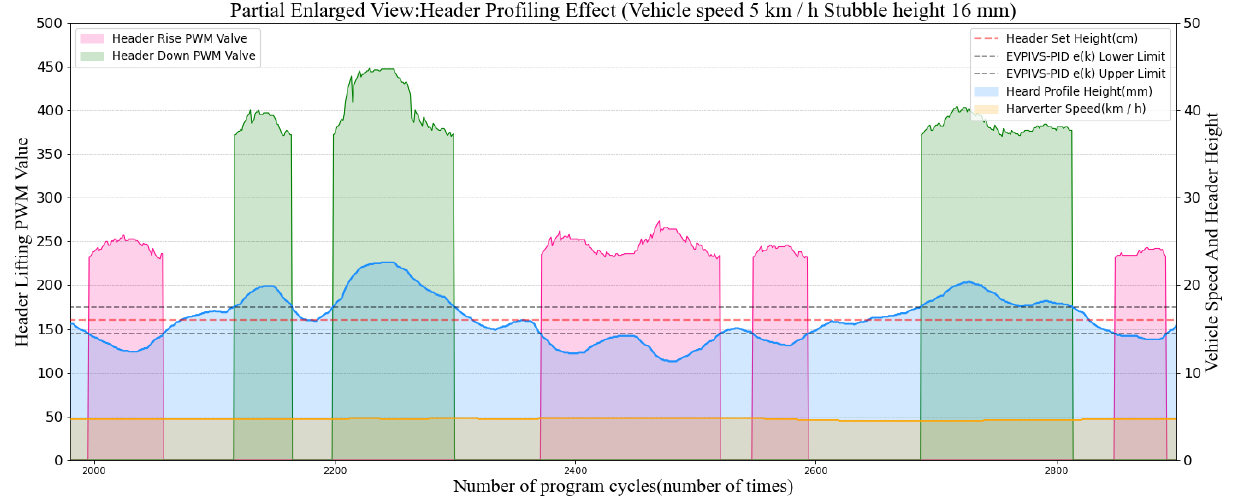
20 of 25 Figure 21. EVPIVS-PID control harvester header height effect. Compare the relevant information of Figure 20 and 21. The traditional manual con- trol header height mode has a large header height fluctuation, and the header vibration amplitude is about 15 cm, up to 30 cm. The header height data of the two control modes are brought into the sample variance formula (19) for calculation. In the traditional man- ual adjustment mode, the sample variance value, 2  , of the header height is 53.4853, while the sample variance value of the header height of the EVPIVS-PID control system is 24.4757. According to the characteristics of sample variance, it can be concluded that the vibration dispersion degree of this height under traditional manual adjustment is higher than that of the EVPIVS-PID control system, and the EVPIVS-PID control system is more